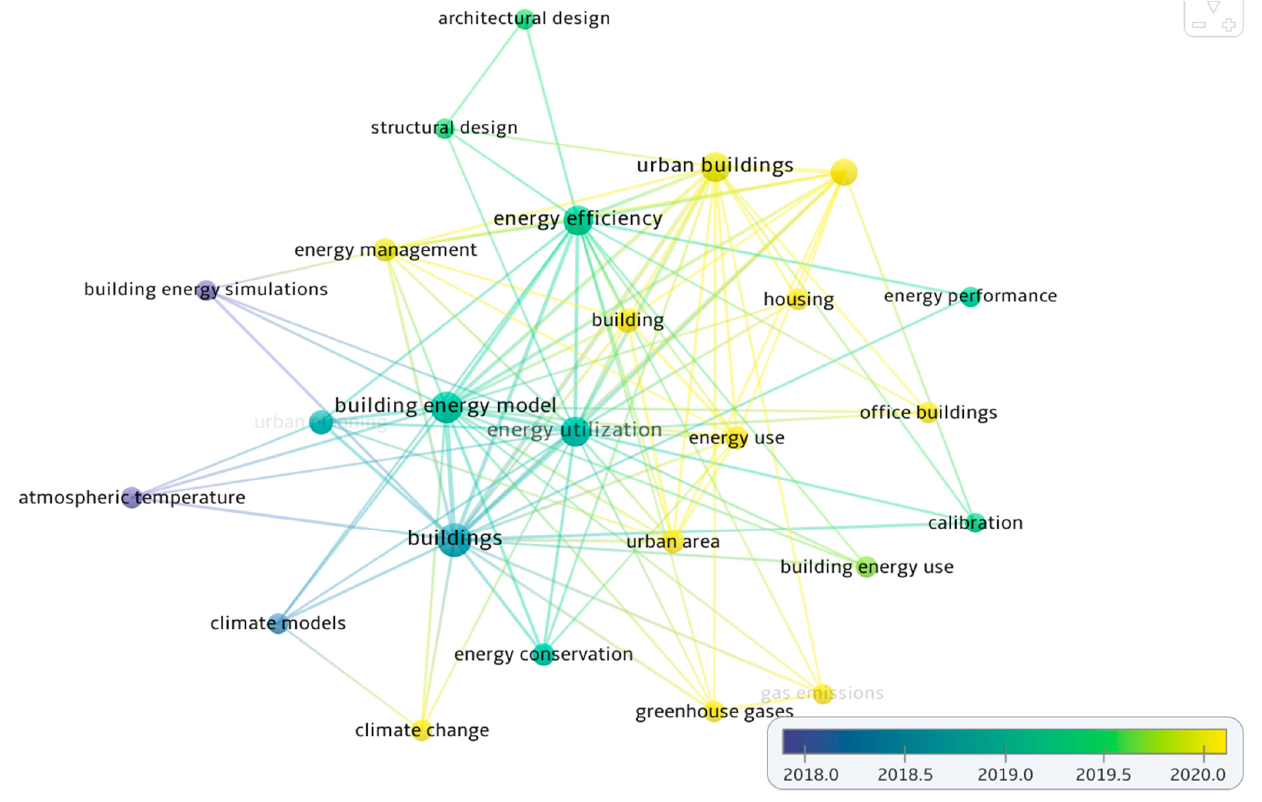
Figure 8. The frequency of different keywords in urban building energy modeling studies before 2018 and after 2020 developed by VOSviewer.